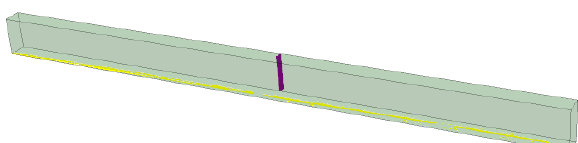
Figure 11. Pedestrian & bus space allocated for bus stop C. The estimated box is coincident with the ground truth.